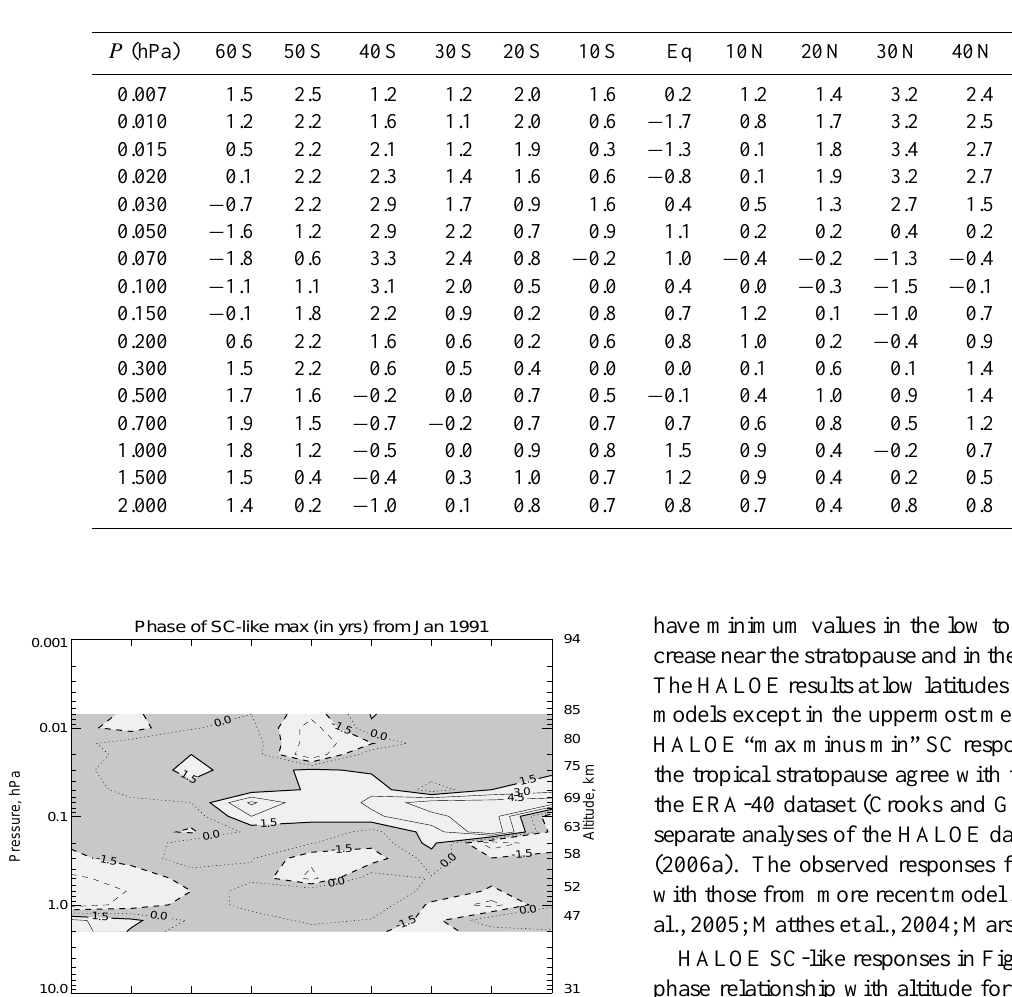
Table 1. Adjusted, Max Minus Min, values of SC-like terms (K).